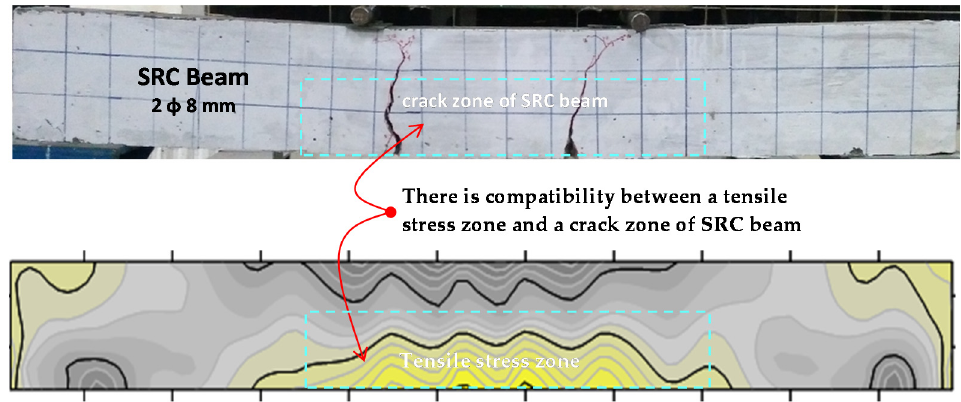
Figure 24. The crack pattern and tensile stress zone of SRC beam. Forests 2020 , 11 , x FOR PEER REVIEW